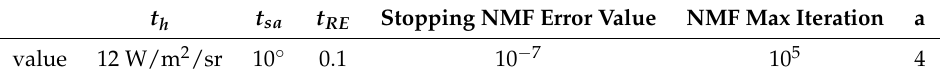
Table 9. HBEE-LSNMF parameter values for the Mauzac data set.